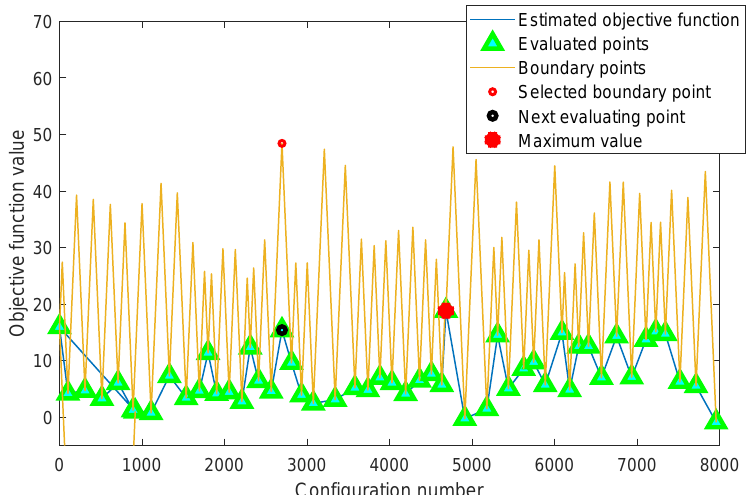
Figure 6. Graphical example of the adaLIPO